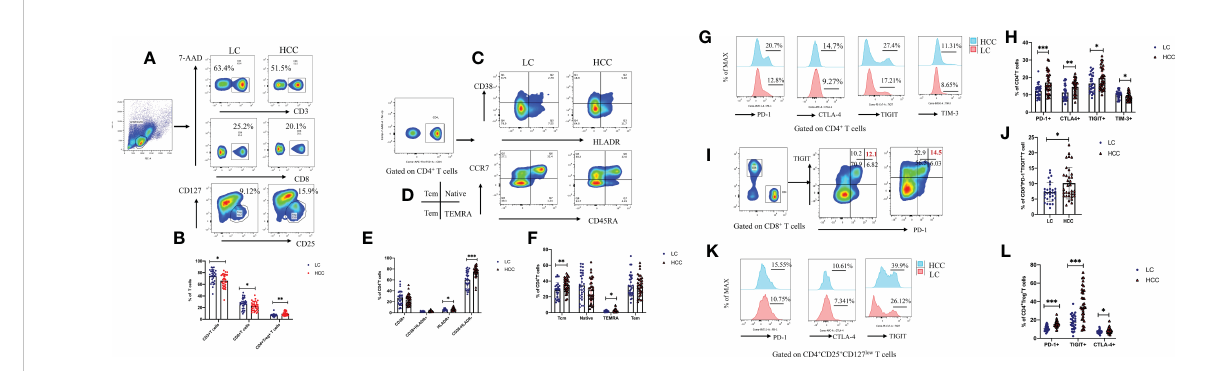
FIGURE 9 Compared with that of HBV-LC patients, the HBV-HCC patients had more severe peripheral immunosuppression phenotype. Fold change from baseline and representative fl ow cytometry plots of CD3+ T cells (CD3+), CD8+ T cells (CD3+CD8+), and Tregs (CD3+CD4+CD25hiCD127low) in response to HC, HBV-LC, and HBV-HCC. Data is represented as % of viable singlets for CD3+T cells, % of viable CD3+ lymphocytes for Tregs and CD8+ T cells, and % of viable CD4+, CD8+ T lymphocytes for T N , T CM , T EM , T EMRA cells, HLA-DR+, CD38+, PD-1, CTLA-4, TIM-3, and TIGIT, normalized to baseline measurements. For panels (A – L) sample size is n=30 for HBV-LC, and n=30 for HBV-HCC (as biologically independent samples). Box plots indicate the median (middle line) and the 25th and 75th percentiles (box). P values are calculated using Tukey ’ s test for 2 group comparisons. Non-normally distributed data were expressed using the median with quartile ranges and analyzed via the Mann – Whitney U test; *P < 0.05, **P < 0.01, ***P <